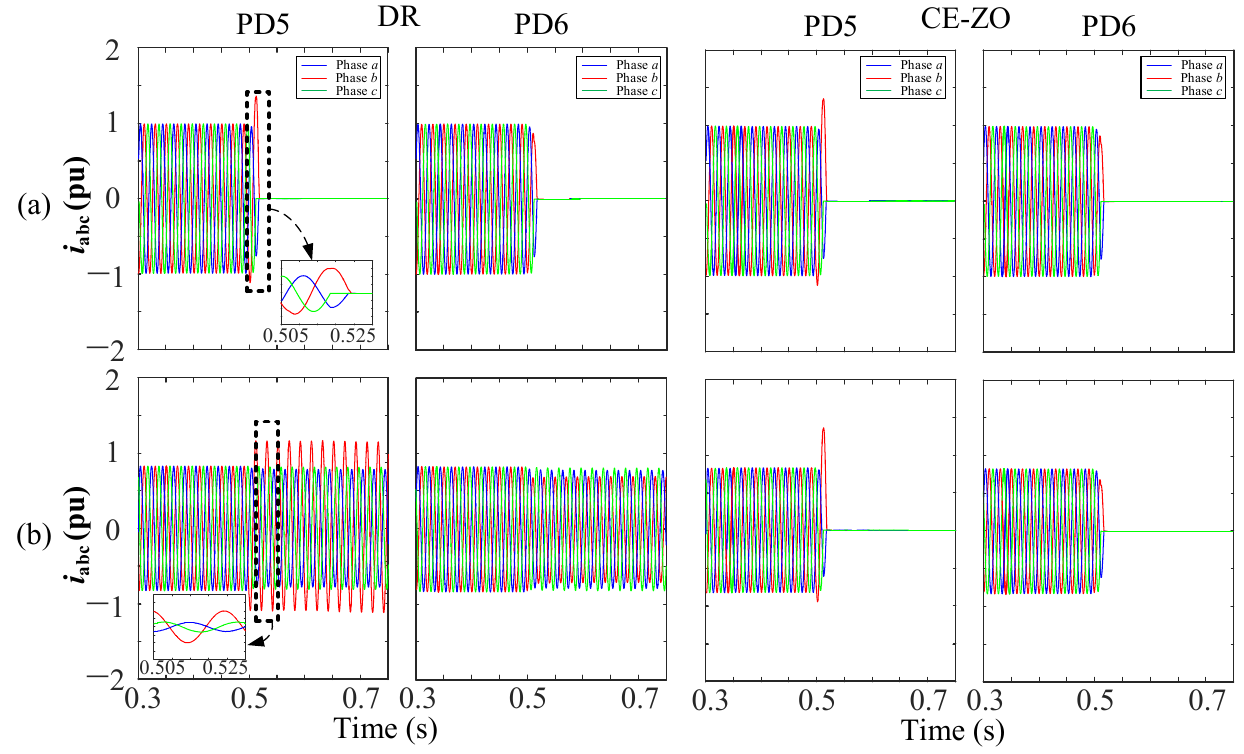
Figure 7. Short-circuit current for DR behavior during a single-phase fault in DL3 with fault resistance r = 0.1 Ω ( a ) without DGs, and ( b ) with two DGs.